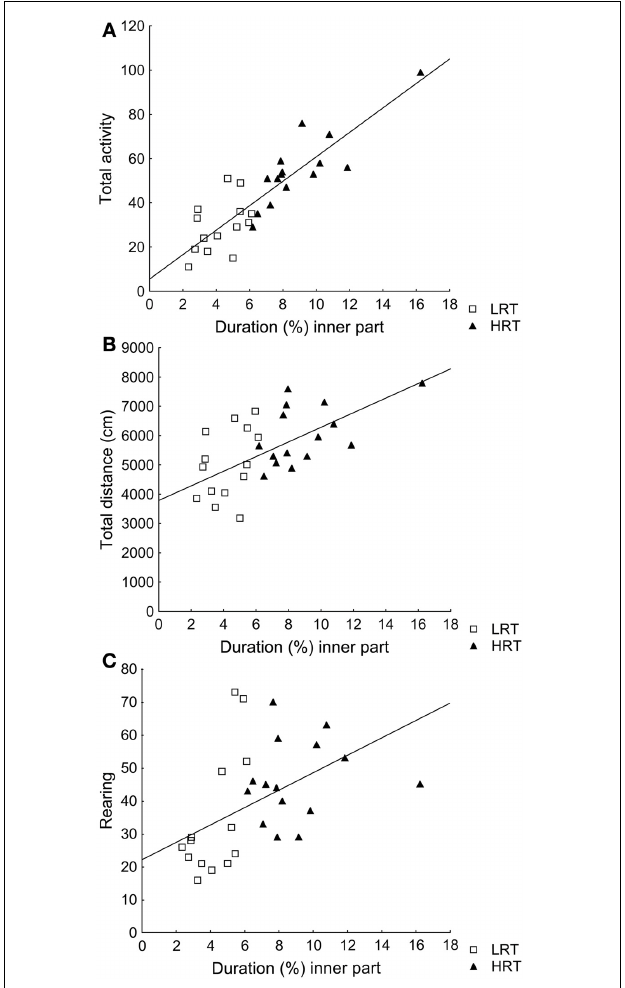
FIGURE 1 | Spearman rank order correlations between the parameter duration (%) in the inner part of the open field, used to classify the animals into the low (LRT, N = 14) or high risk taking (HRT, N = 15) groups, and (A) the total activity [ ρ = 0 . 85; p < 0 . 001], (B) the total distance traveled [ ρ = 0 . 59; p < 0 . 001], and (C) rearing [ ρ = 0 . 60; p < 0 . 001] in the open field